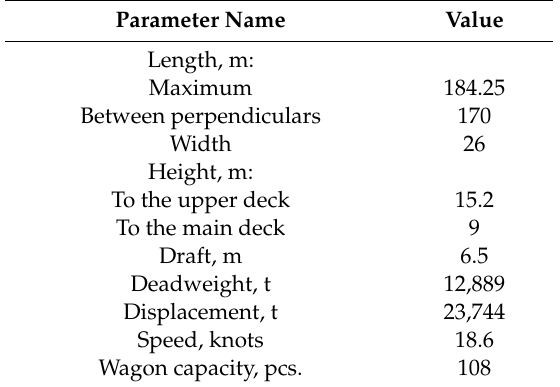
Table 1. Main technical characteristics of the ship ferry “Heroes of Shipka”.